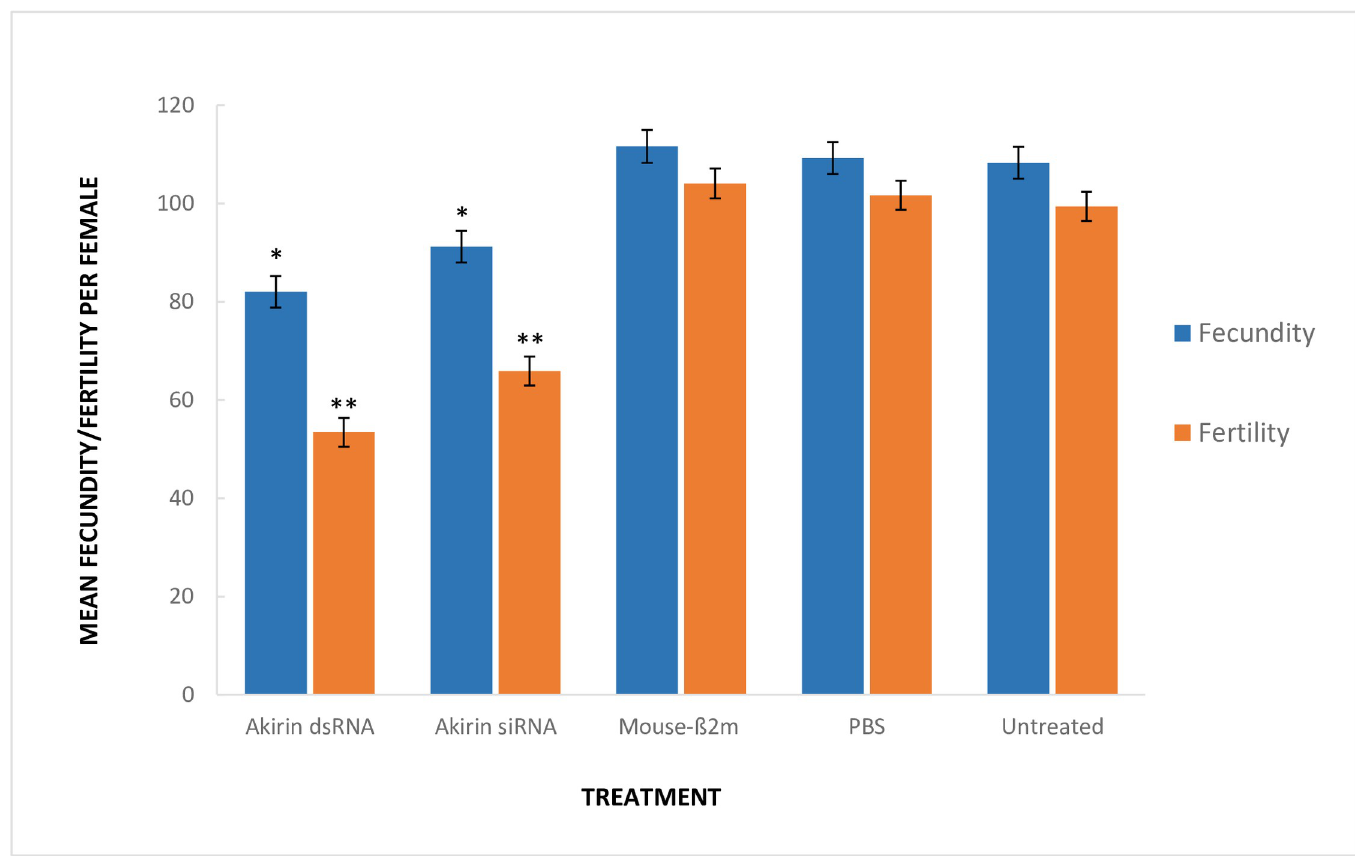
Fig 2. Mean vector fecundity (blue) and fertility (orange) per treatment. Akirin knockdown mosquitoes had a reduced mean fecundity by 17–25% (one-way ANOVA: p < 0.01, F = 16.5, DF = 4), and a reduced mean fertility by 23–29% (one-way ANOVA: p < 0.01, F = 63.4, DF = 4), when compared to the control treatments. This was a 19–26% decrease in hatch rate percentage. No significant change in fecundity/fertility was observed between the control treatments. The asterisks indicate a significant change from the control